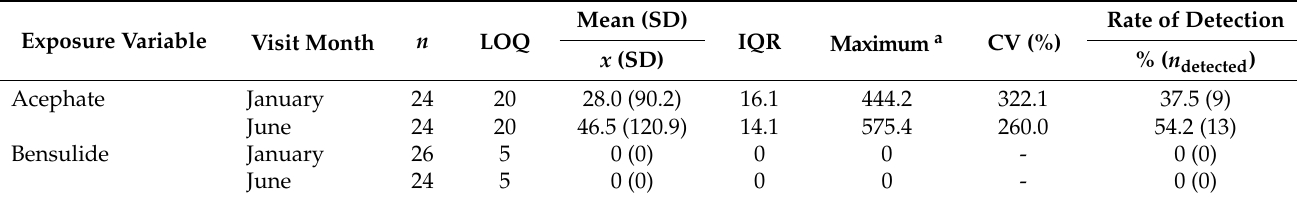
Table 2. Household Dust OP Concentrations